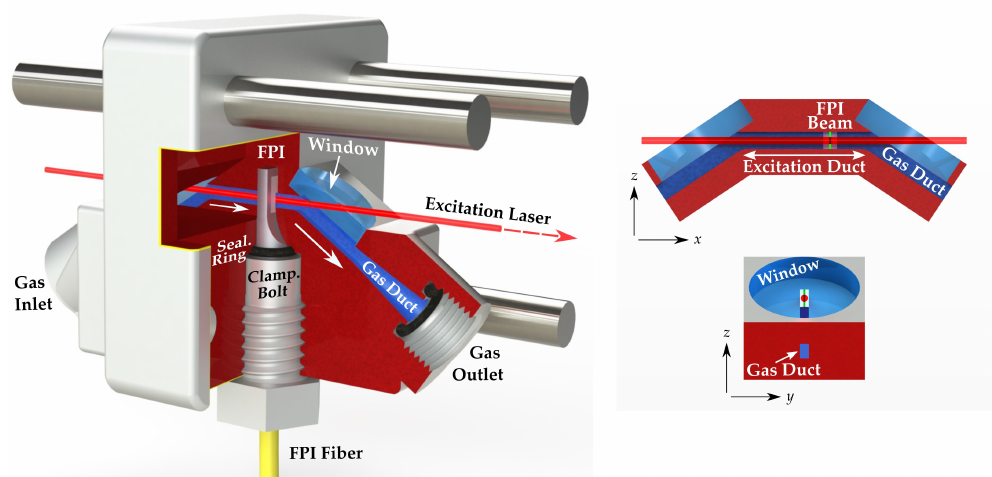
Figure 2. Photothermal cell used for the PTS measurements. The excitation laser beam with a 1/ e 2 radius of 0.43 mm is aligned collinearly to the movement direction of the gas in the excitation channel. The beam enters the cell through a window arranged at the Brewster angle. The fiber-coupled, air-spaced etalon for monitoring the RI is fitted firmly into the channel system and held gas-tight by a clamping bolt and a sealing ring. Areas colored in red and blue symbolize a sectional view through the cell and its gas duct system, respectively, which serves solely for visualization. The FPI probe beam (green) in the upper right sketch is drawn to scale as FWHM for